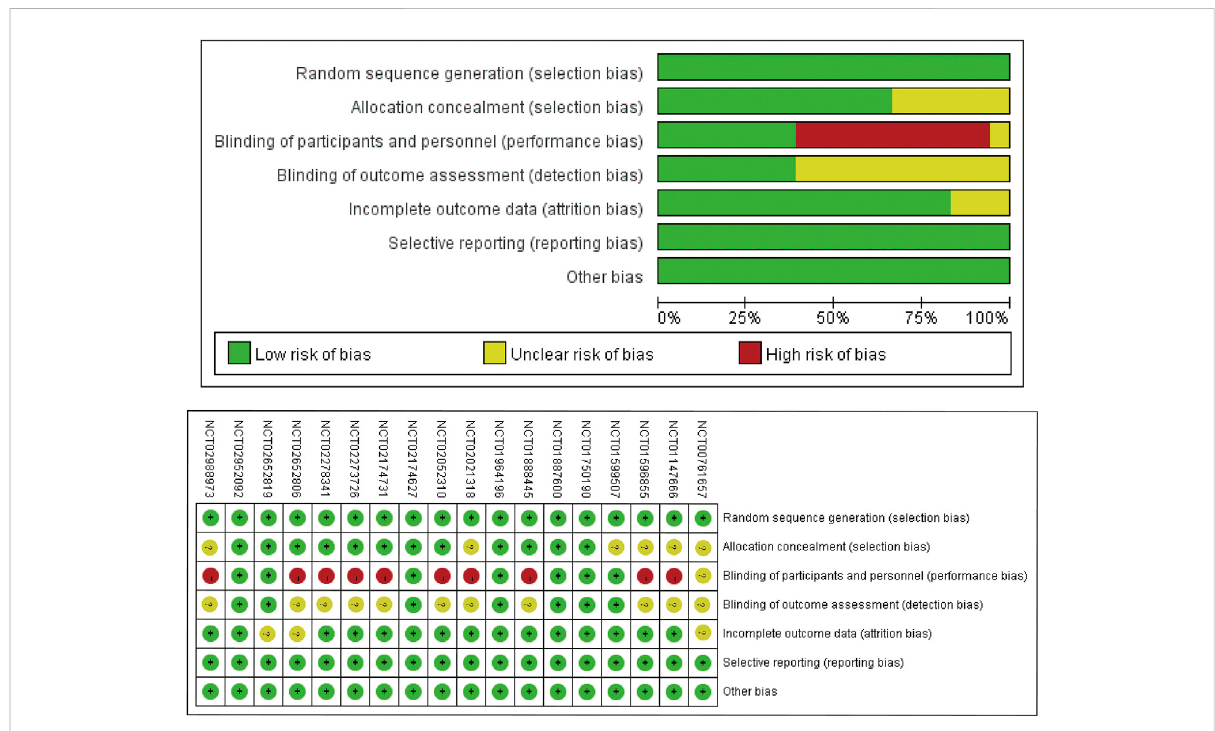
FIGURE 2 Risk of bias summary. Abbreviations: NCT, National Clinical